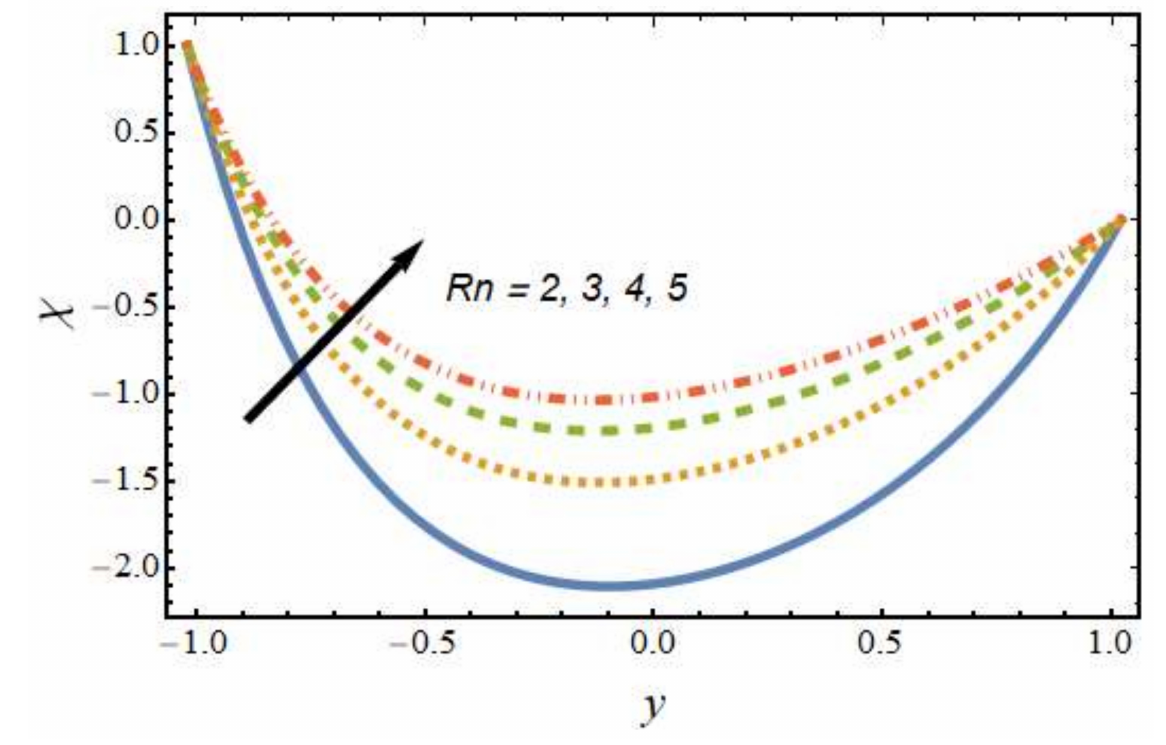
Figure 16. Motile microorganism profile for various values of the radiation parameter.